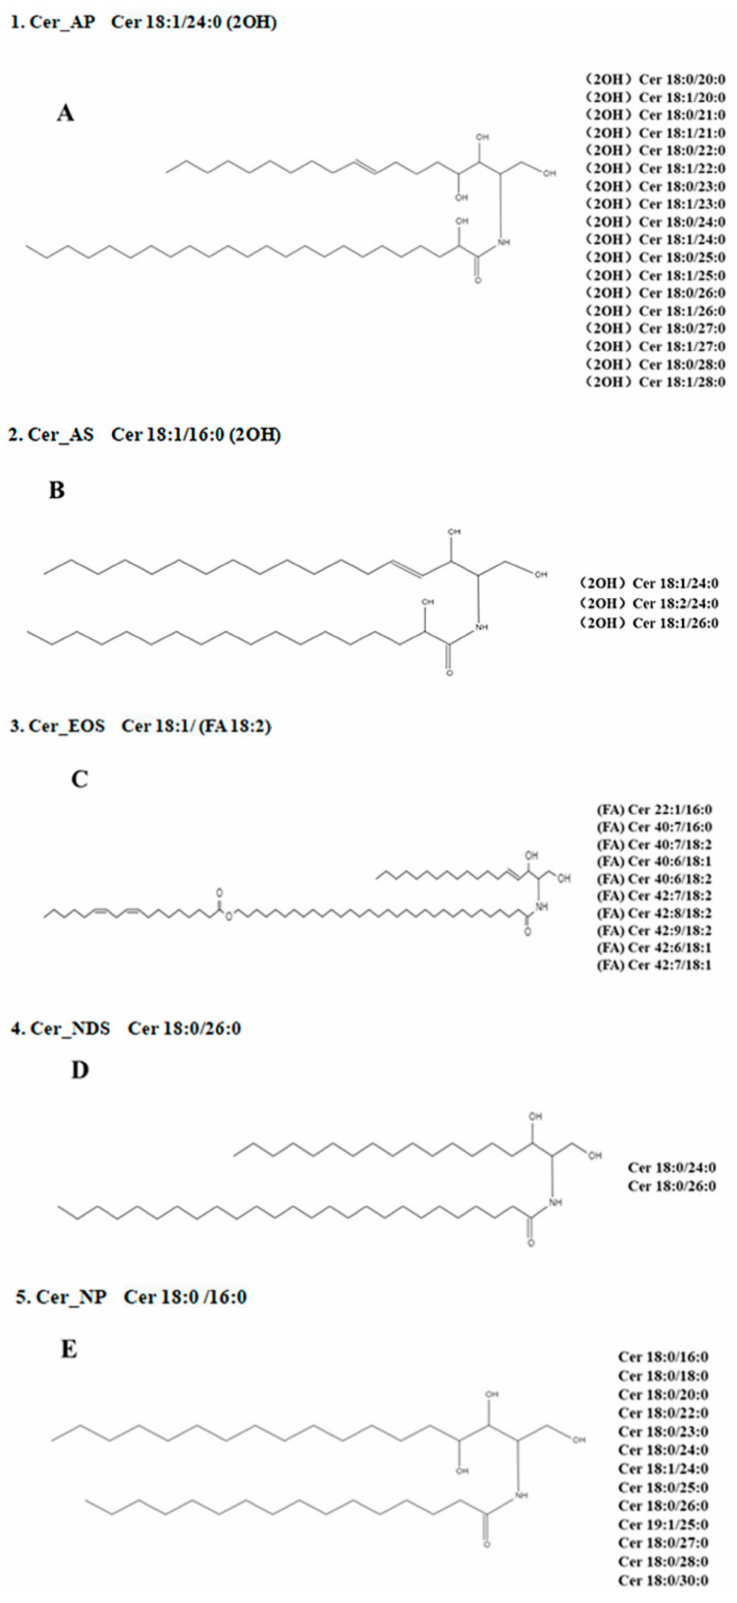
Figure 5. Structures of unique Cers in sea red rice bran (main category). ( A – E ) is the most impor- tant five types of Cers in sea red rice bran. N and EO indicate amide-linked FA species: N, non- hydroxy FA; A, a-hydroxy FA; and EO, omega-O-esterified FA. S, DS, and P indicate sphingoid bases: S, sphingosine; DS, dihydro-sphingosine; and P,